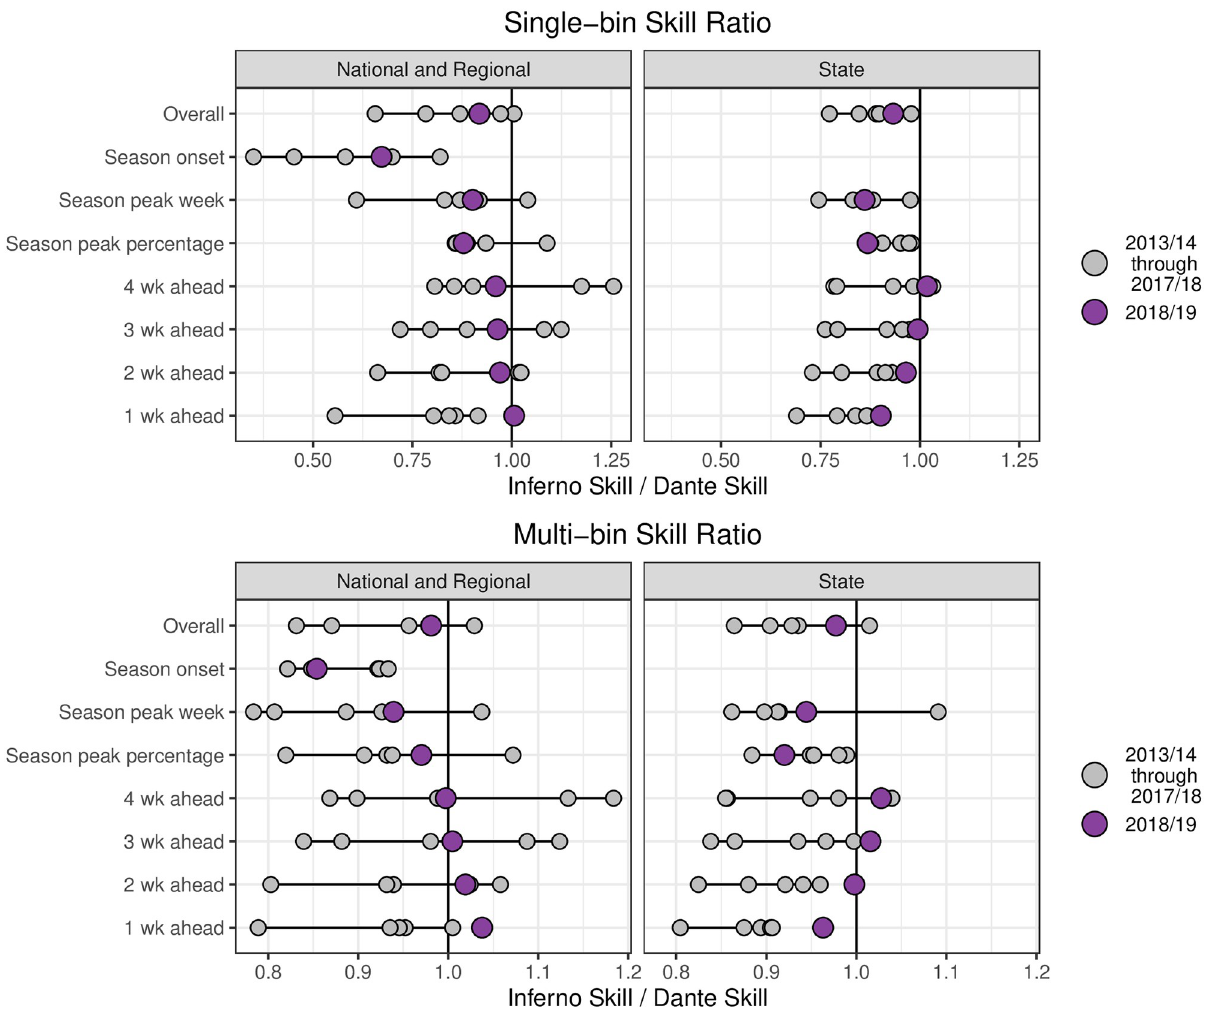
Fig 13. Retrospective comparison of Dante’s and Inferno’s single-bin (top) and multi-bin (bottom) skills for the 2013/14 through 2017/18 flu seasons (grey points) and the pseudoprospective comparison of the 2018/19 season (purple points). Skill ratios less than one (Inferno/Dante) indicates better performance by Dante. For most season/targets, Dante had a higher skill than Inferno. Inferno’s relative performance to Dante in 2018/19 was largely consistent with past season comparisons, with Inferno’s short-term forecasts for states performing better than usual in 2018/19 relative to Dante than in past